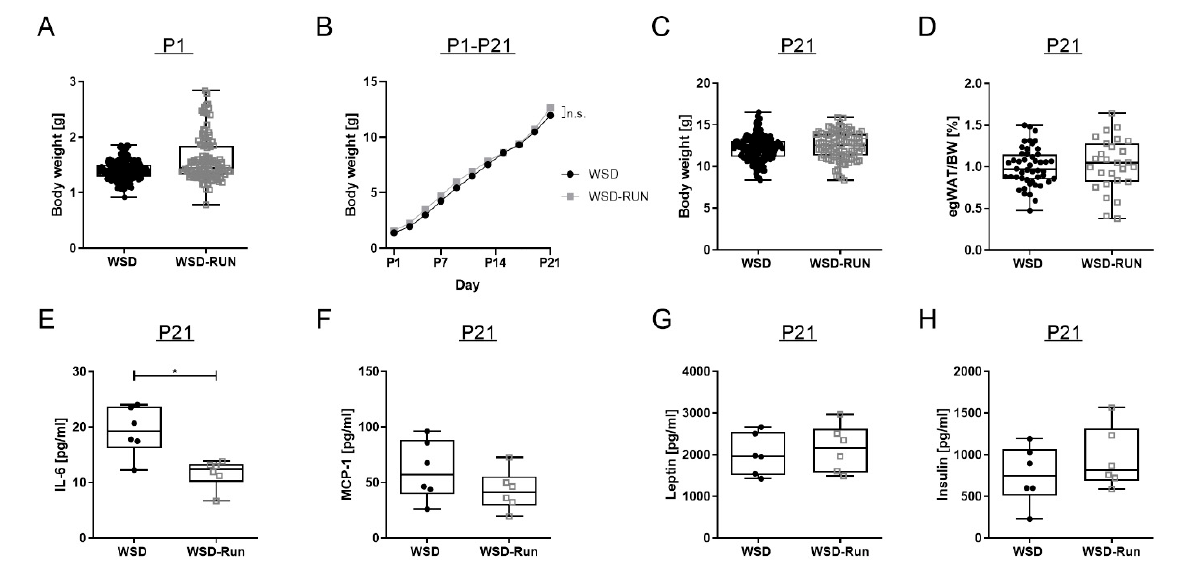
Figure 4. Maternal exercise before and during pregnancy shows no influence on offspring’s body weight and body composition in early life (P21). ( A ) Offspring total body weight a birth (P1). ( B ) Offspring body weight gain during the lactation period (P1–P21). ( C ) Offspring total body weight at weaning at postnatal day P21 (WSD group (n = 179), WSD-Run group (n = 94)). ( D ) Offspring epigonadal fat pad weight at P21 (WSD group (n = 49), WSD-group (n = 28)). ( E – G ). Serum analyses of IL-6 ( E ), MCP-1 ( F ), leptin ( F ) and insulin, ( F ) using multiplex assays in offspring at weaning (P21) (WSD group (n = 6), WSD-group (n = 6)). Data are presented as mean ± standard deviation; * p < 0.05. IL-6, interleukin 6; MCP-1, monocyte chemoattractant protein-1; p , postnatal day.